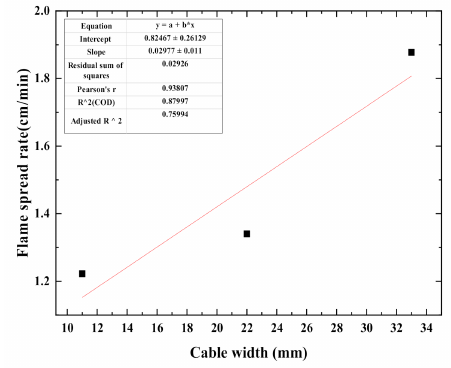
Figure 11. Fitting relationship between cable flame-spread rate and cable